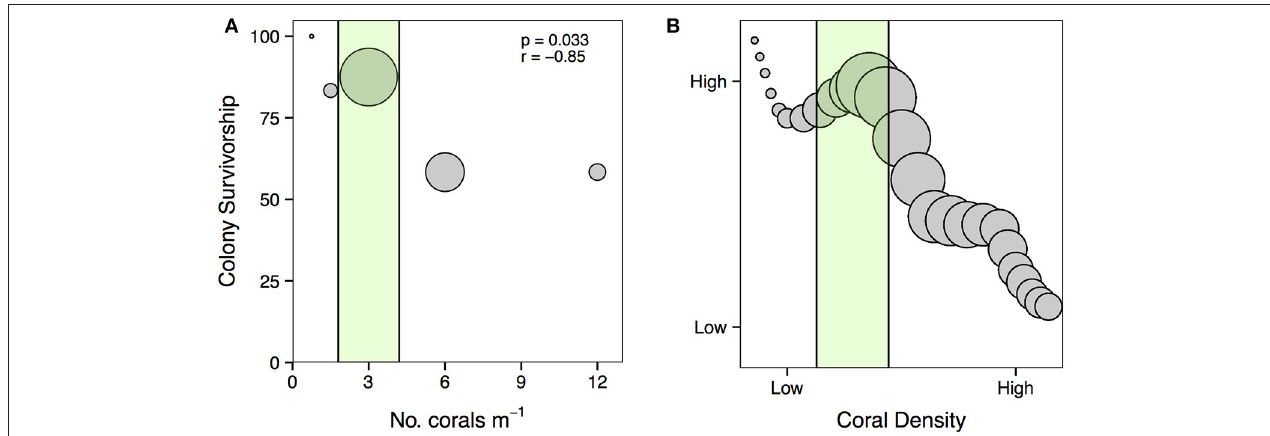
FIGURE 9 | (A) Relationship between the density of A. cervicornis outplanted for restoration and colony survivorship. The size of each point is scaled to the average amount of live TLE (i.e., habitat created) for each treatment at the conclusion of the experiment. The green area represents the densities over which positive density dependence may facilitate coral survivorship and habitat production. Statistics from Pearson’s product-moment correlation ( df = 3). (B) Proposed relationship between the density of A. cervicornis outplanted for restoration, colony survivorship, and habitat production. Points are scaled to the amount of live habitat created, thus larger circles represent more habitat generation. The green area highlights densities where restoration practitioners can take advantage of positive density-dependence to maximize the benefits of coral restoration.